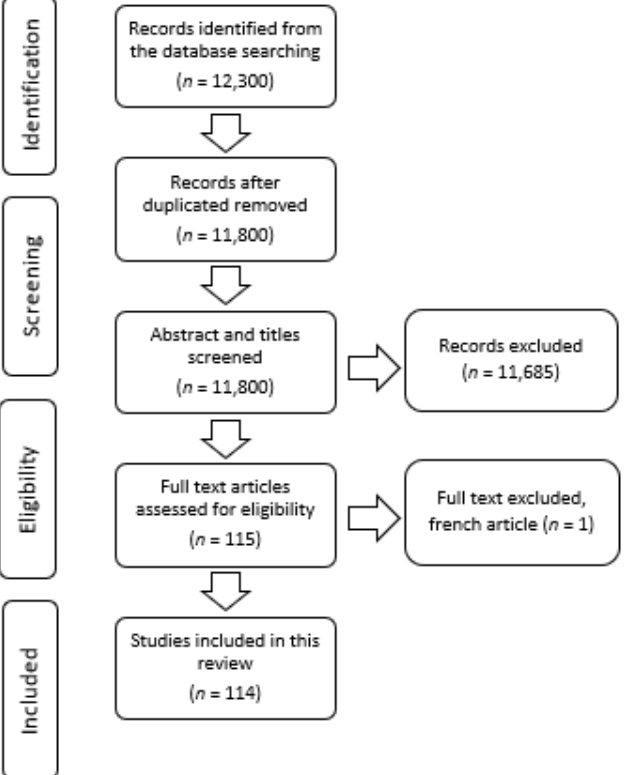
Figure 1. Search flow chart illustrating the number of studies and reports evaluated and subsequently included in the review. ( n = number of studies).